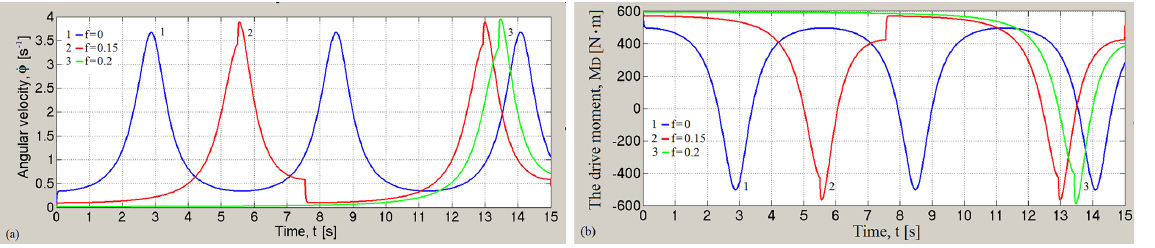
Figure 18. Graphs of angular velocity of the rotation of ˙ ϕ ( t ) driving link (engine shaft) (a) and engine torque M D (b) at different values of the coefficient of sliding friction f and for coefficient of rotational friction k = 0 and for load mass M = 500kg.